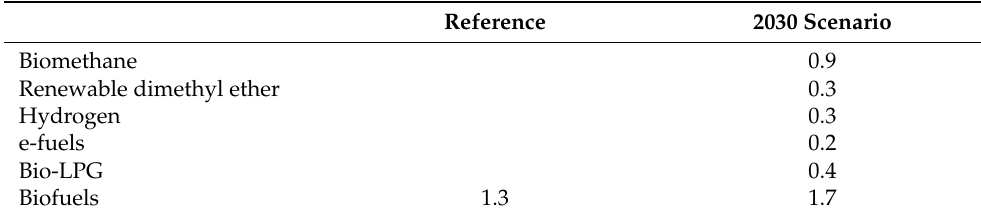
Table 2. The final consumption of green fuels in transportation (Mtoe).